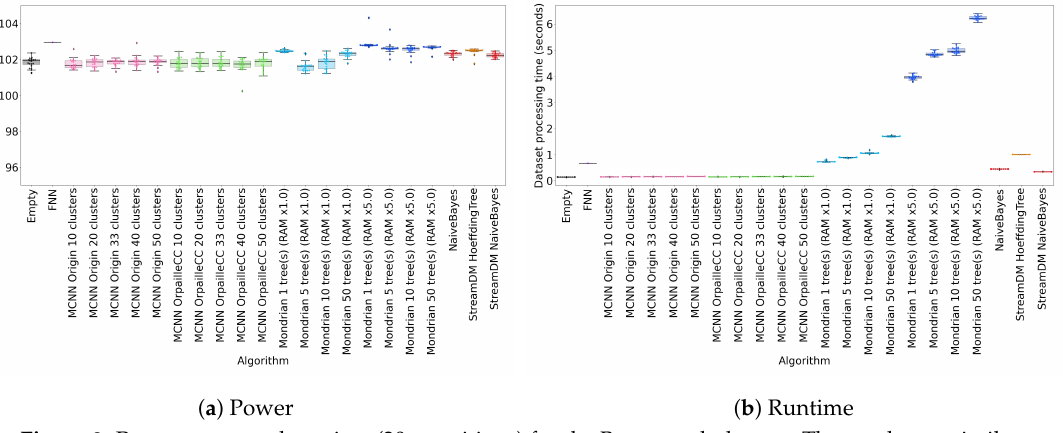
Figure 2. Power usage and runtime (20 repetitions) for the Banos et al. dataset. The results are similar across